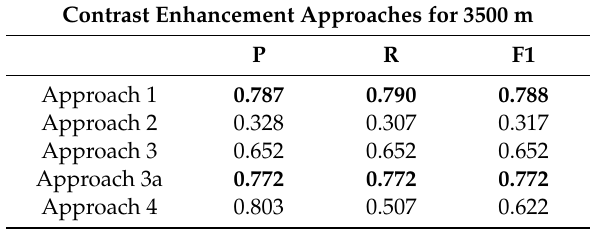
Table A1. Performance metrics for contrast-enhanced approaches within the proposed Python workflow with SORT for 3500 m range. Bold are the best